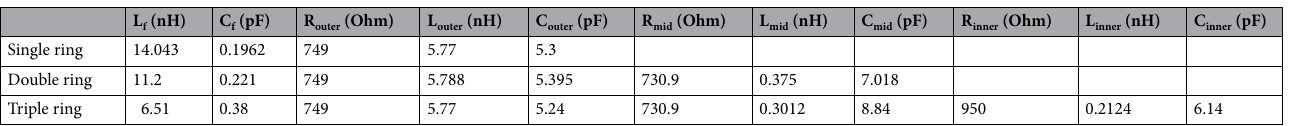
Table 2. The parameter values in the equivalent circuit